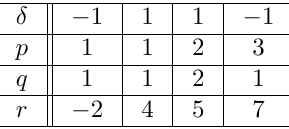
Table 2: Values of δ , p , q and r from Theorem